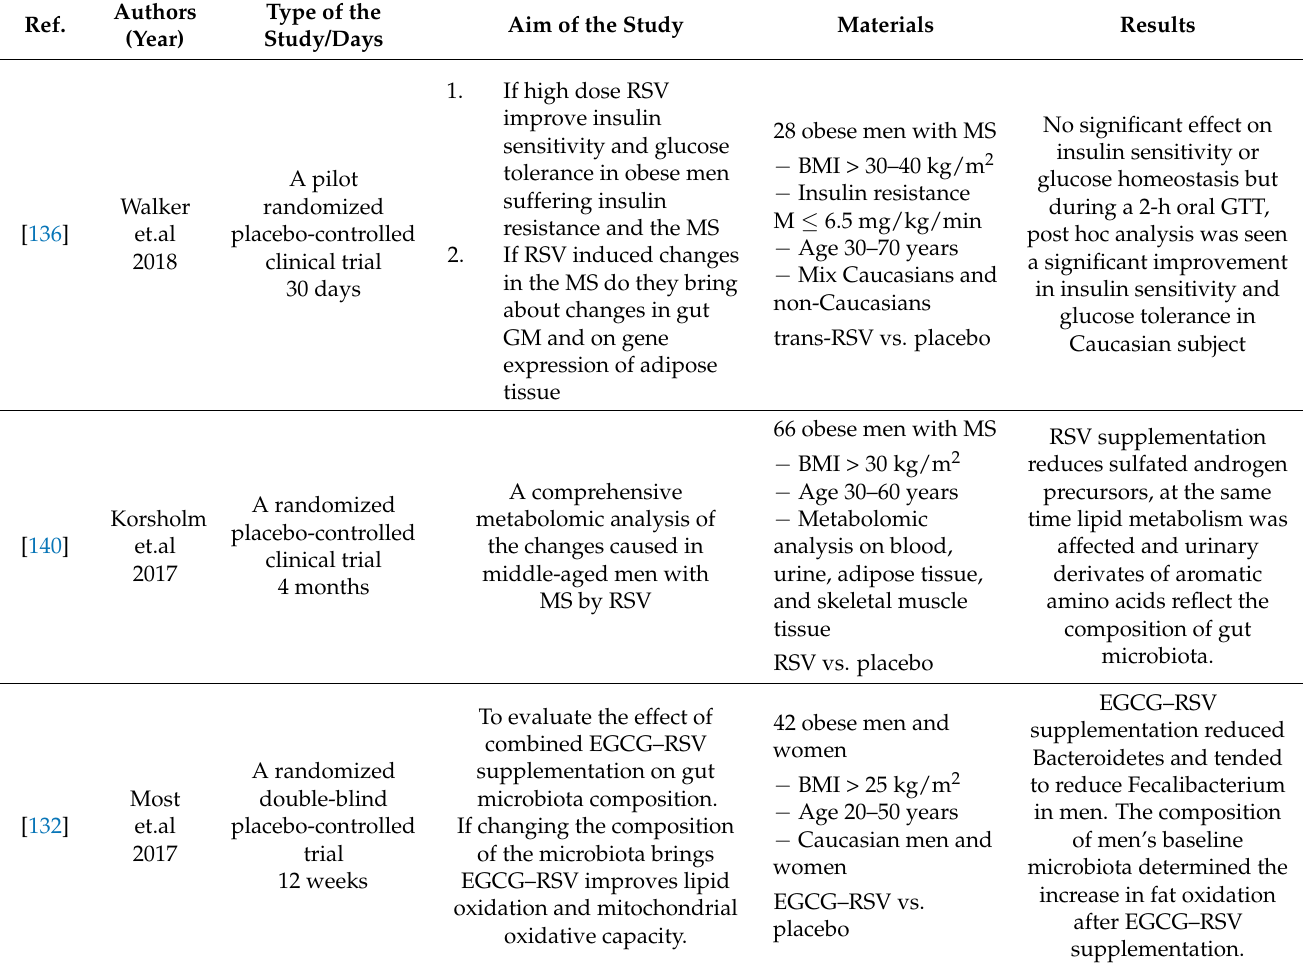
Table 2. Reported RSV results in obese individuals with metabolic